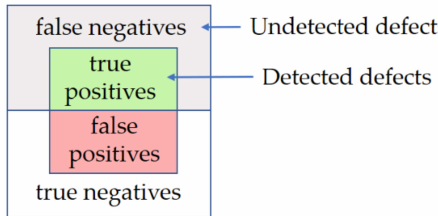
Figure 9. The definition of true positive (TP), false positive (FP), false negative (FN) and true negative (TN) of detected defects and true